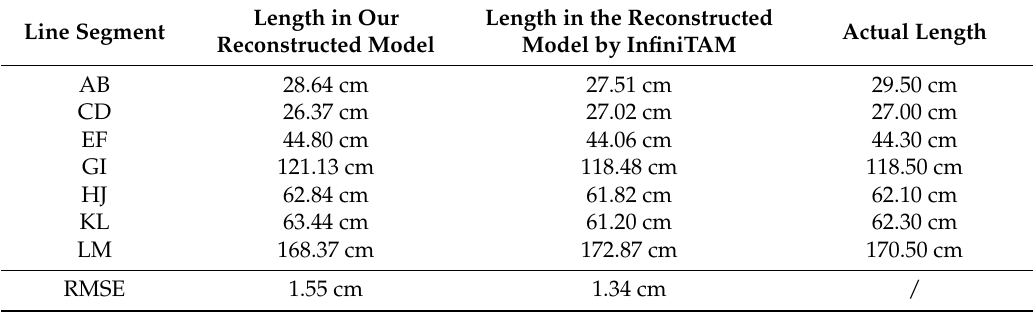
Figure 9. Comparison of single-camera SLAM result and two-camera SLAM result when one of the cameras is occluded. ( a ) is the single-camera SLAM result; ( b ) is the two-camera SLAM result. From the above experiments, we firstly demonstrate the accurate extrinsic calibration with multiple cameras which share no common field of view for two different applications, one is for a robot with inertial sensors system, the other is for a tripod with the camera only system. The accuracy of odometer-based calibration method is more accurate than SLAM-based calibration method. However, the accuracy of combined method is the most accurate method. How to choose the calibration method is based on the hardware. Secondly, we show that our tracking and mapping method can make an accurate 3D reconstruction and the RMSE of the lengths measured in our reconstructed mode is 1.55 cm (similar to the state-of-art single camera RGB-D SLAM systems). The overall average processing time is 23 ms per frame and can be used for real-time operation. Thirdly, we make the pipeline robust to breaks in monocular visual odometry which occur in areas with low texture or occluded by pedestrians.